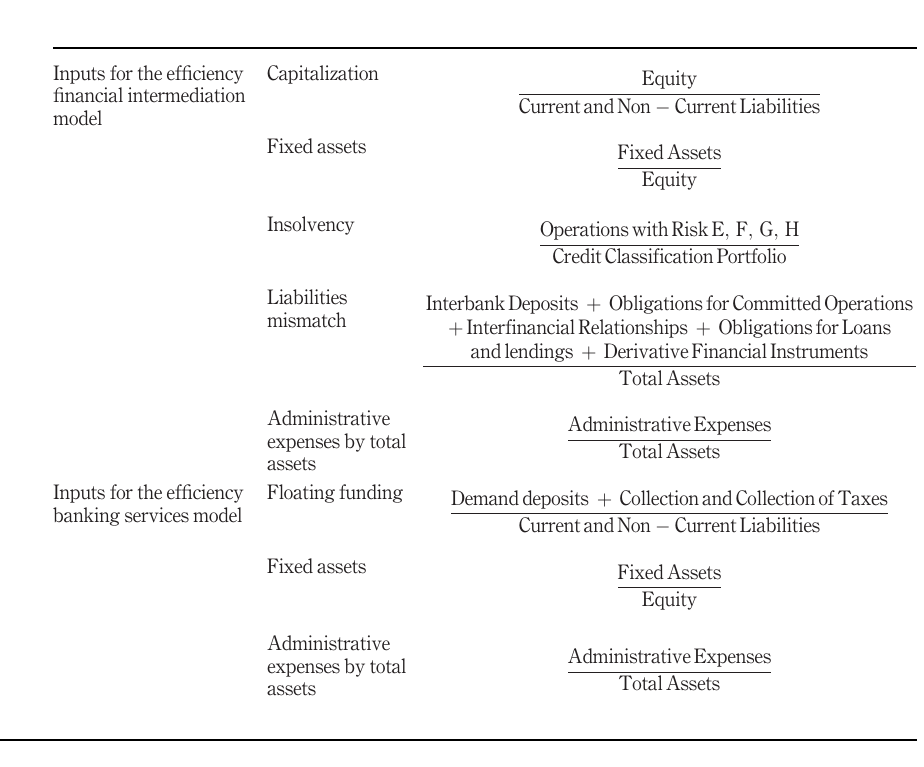
Figure 1 allows the visualization of the evolution of the number of cooperatives regarding the ef fi ciency in fi nancial intermediation over the period under study.